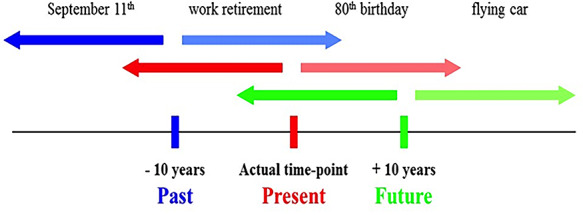
Stimuli and procedure. Participants were required to project themselves in three different locations of subjective time (past, present or future) (self-projection), and to determine whether events were past or future relative to the currently assumed location in subjective time (self-reference).